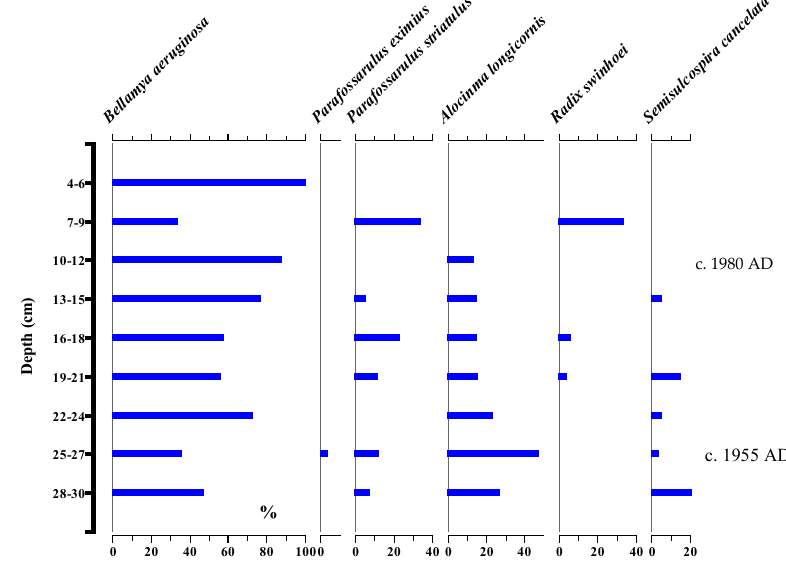
Figure 9. Sediment stratigraphy of subfossil gastropods (relative abundance) in Changdang Lake in the lower Yangtze River.